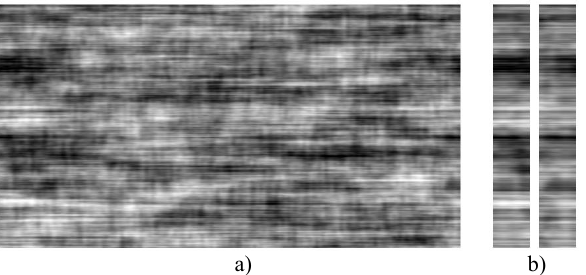
Figure 4. Simulated images: a) image simulated by model (4), b) the first and the last five columns of this image The characteristic equation of model (4) is